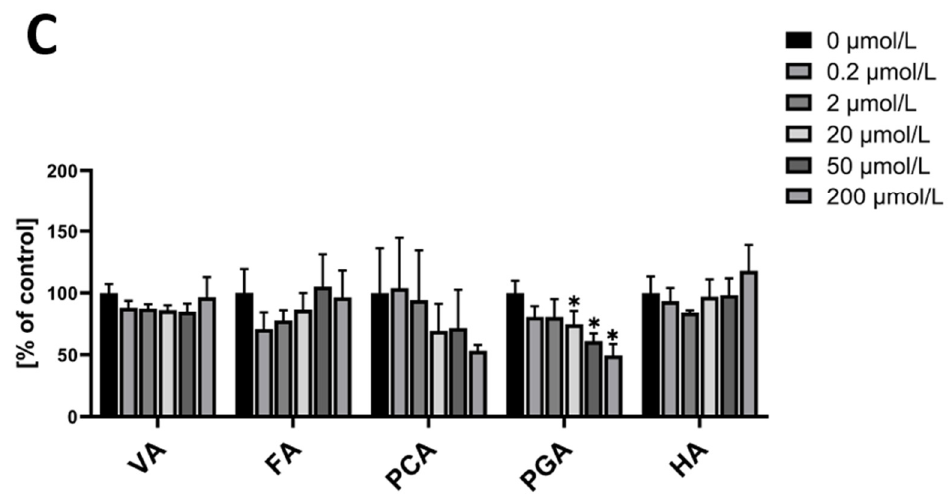
Figure 2. DCF-DA fluorescence relative to control in hmvEC with the respective concentrations of single anthocyanins ( A , B ) and the respective concentrations of anthocyanin metabolites ( C ); results are expressed as mean ± SD; * p < 0.05 compared to 0 µg/mL of the respective substance; n = 4 technical replicates.